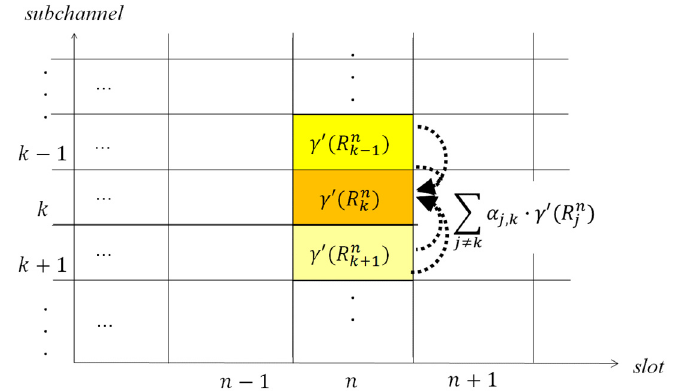
Figure 3. In-band emission (IBE)-induced interference from other subchannels.